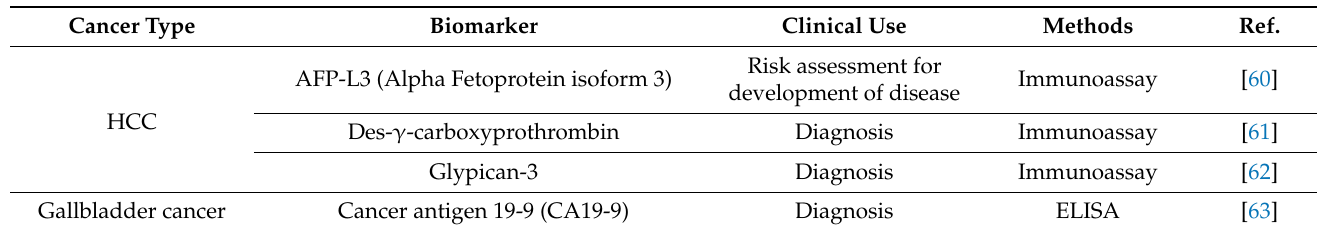
Table 3. List of conventional serum-based biomarkers for various